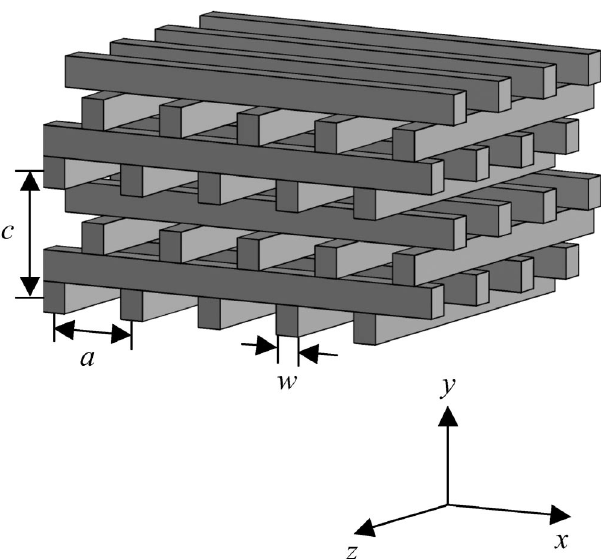
FIG. 1. A diagram of 8 layers (2 vertical periods) of the woodpile lattice.